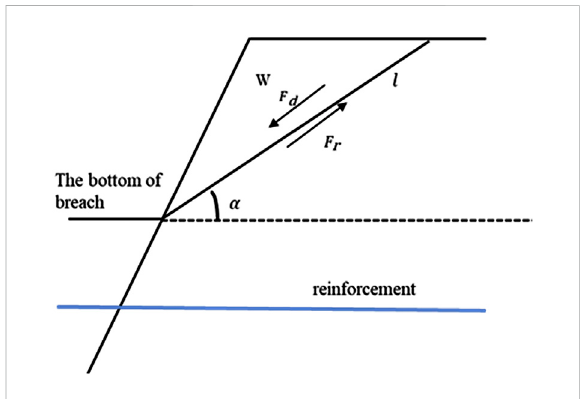
FIGURE 1 Schematic diagram of reinforcement not yet